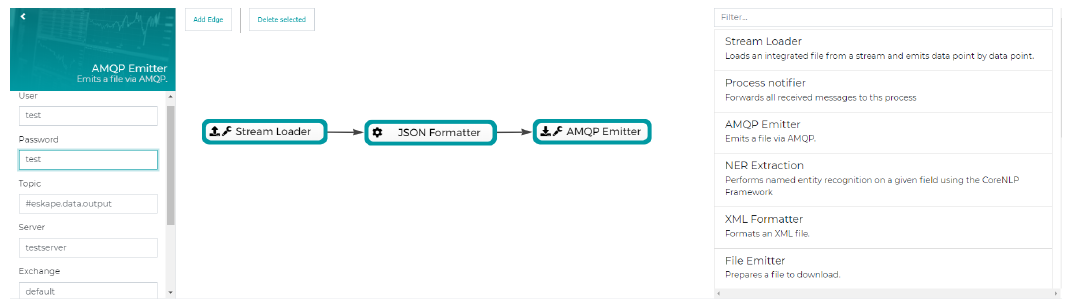
Figure 11. Data extraction using an Advanced Message Queuing Protocol (AMQP) emitter in a processing